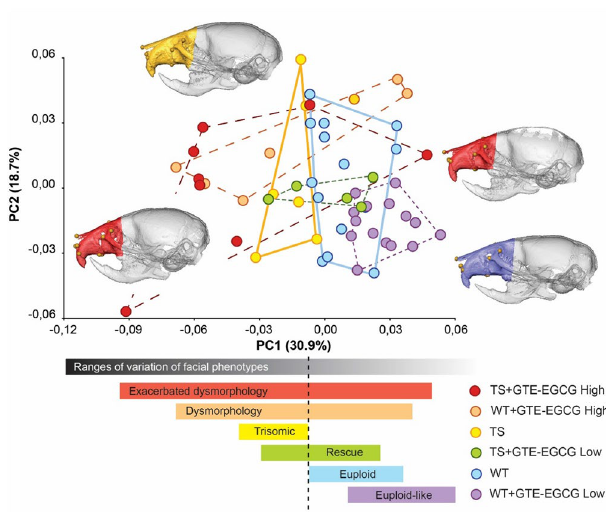
Figure 1. Principal Component Analyses of the global facial shape variation in Ts65Dn trisomic (TS) mouse models treated with high and low GTE-EGCG doses and euploid wild-type (WT) mice. Scatterplot of PC1 and PC2 axes with the corresponding percentage of total morphological variation explained is displayed along each axis. Convex hulls and horizontal color bars represent the ranges of variation within each group of mice. To visualize facial shape changes associated with positive and negative extremes of PC1 and PC2, skull CT reconstructions of mice occupying these positions are displayed. Note that although the complete skull is displayed for anatomical reference, only landmarks located on the colored facial region have been used for the analysis. Colors correspond to mice groupings. The red colored skull to the far right representing a TS mouse treated with a high dose of GTE-EGCG exhibited poor bone mineral density as evidenced by the nearly transparent regions of cranial vault bones. See Fig. S3 to further visualize facial shape changes associated to PC1, which is the axis that explains most morphological variation and separates groups based on genotype. Mice skull reconstructions were obtained from NRecon and Amira, and landmarking was performed with